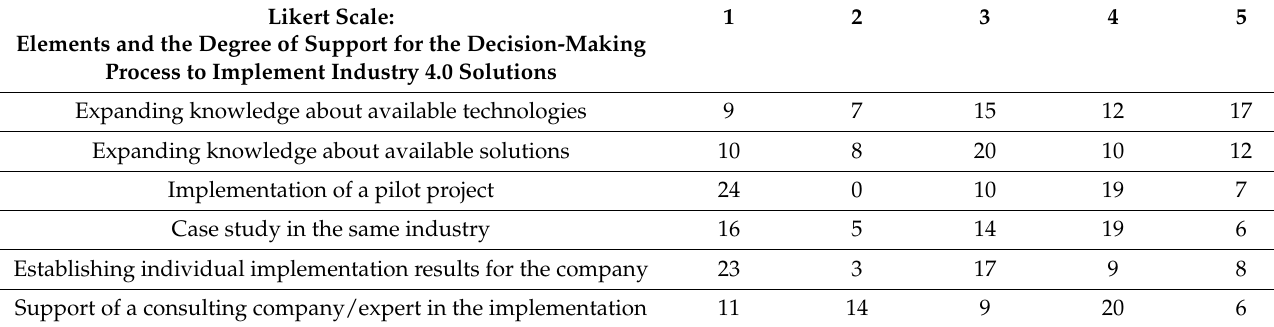
Table 15. Decision-making process to implement Industry